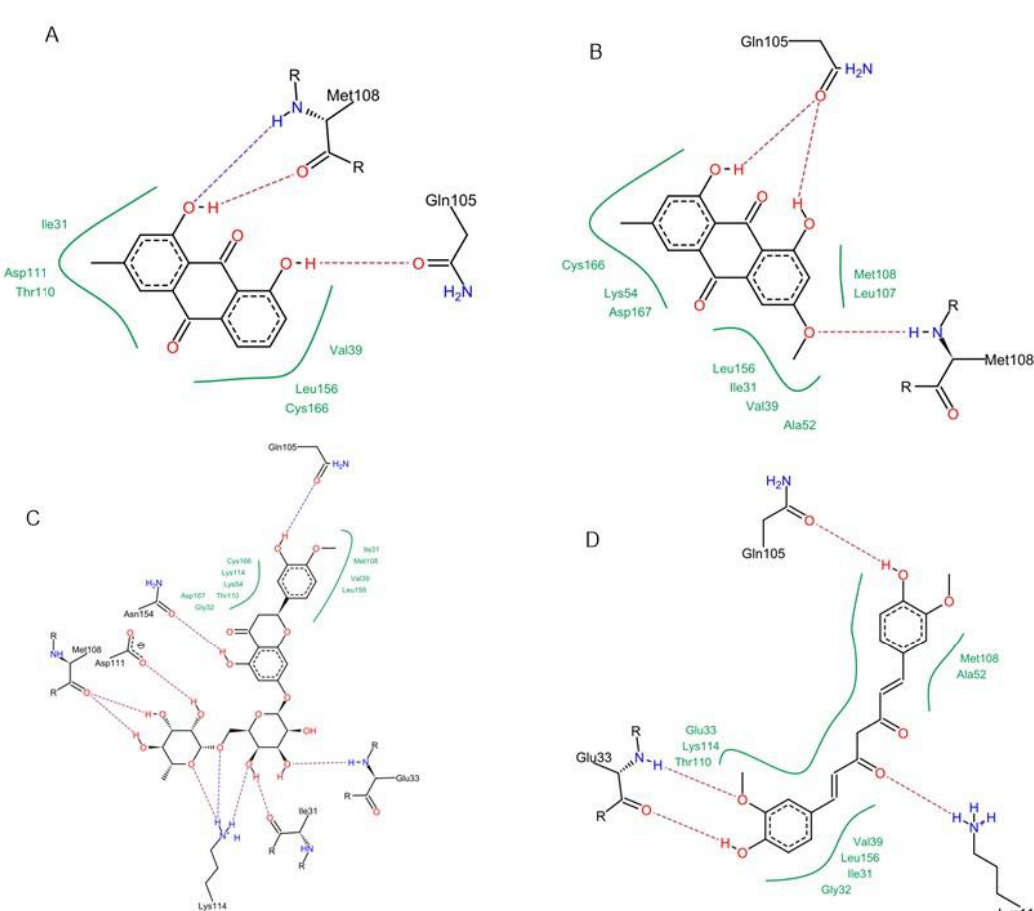
Figure 11. 2D Protein-ligand binding interaction diagram of chrysophanol ( A ), physcion ( B ), hesperidin ( C ) and curcumin ( D ) with ERK1/2 MAPK (PDB ID: 5NHF).